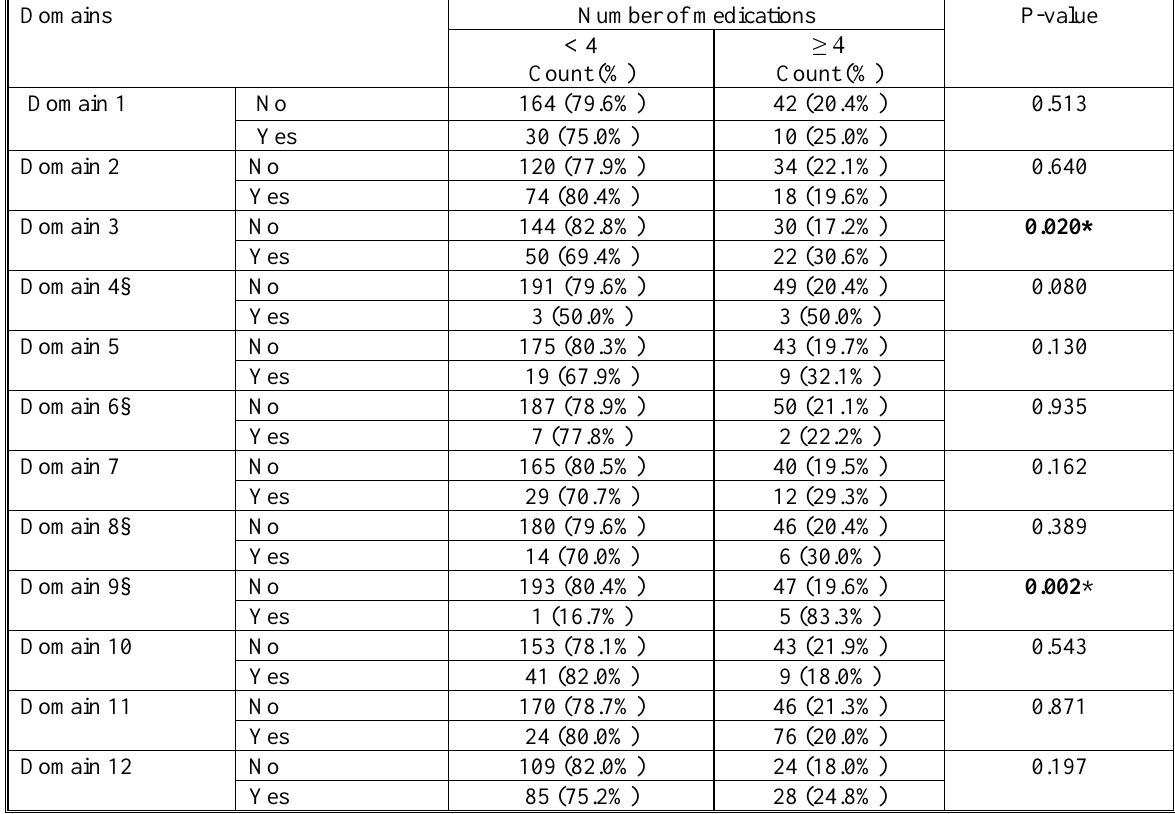
Table 7. The relationships between the number of scheduled medications and the study domains Domains